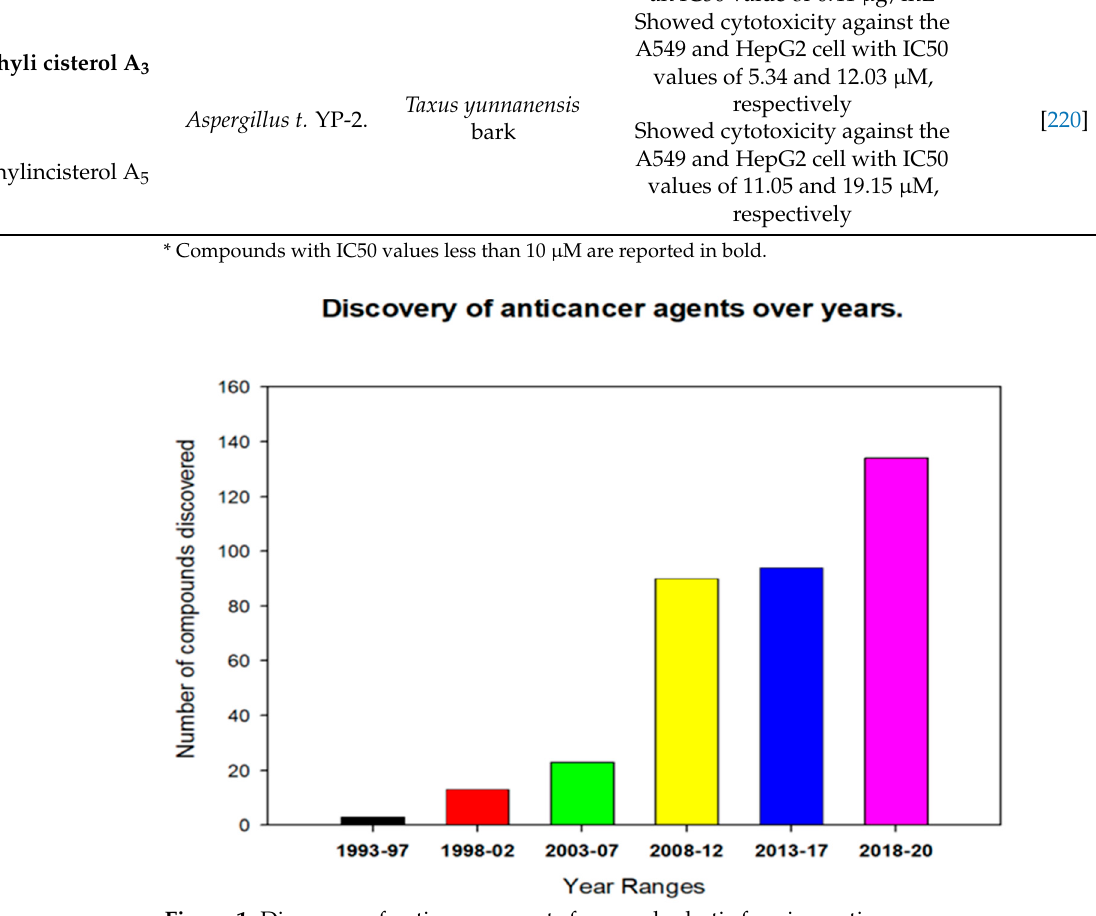
Figure 1. Discovery of anticancer agents from endophytic fungi over time.